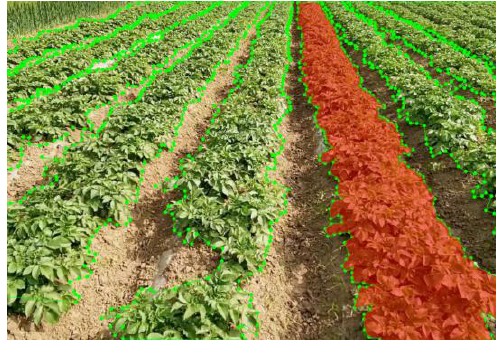
Figure 3. LabelMe labeled potato crop rows.